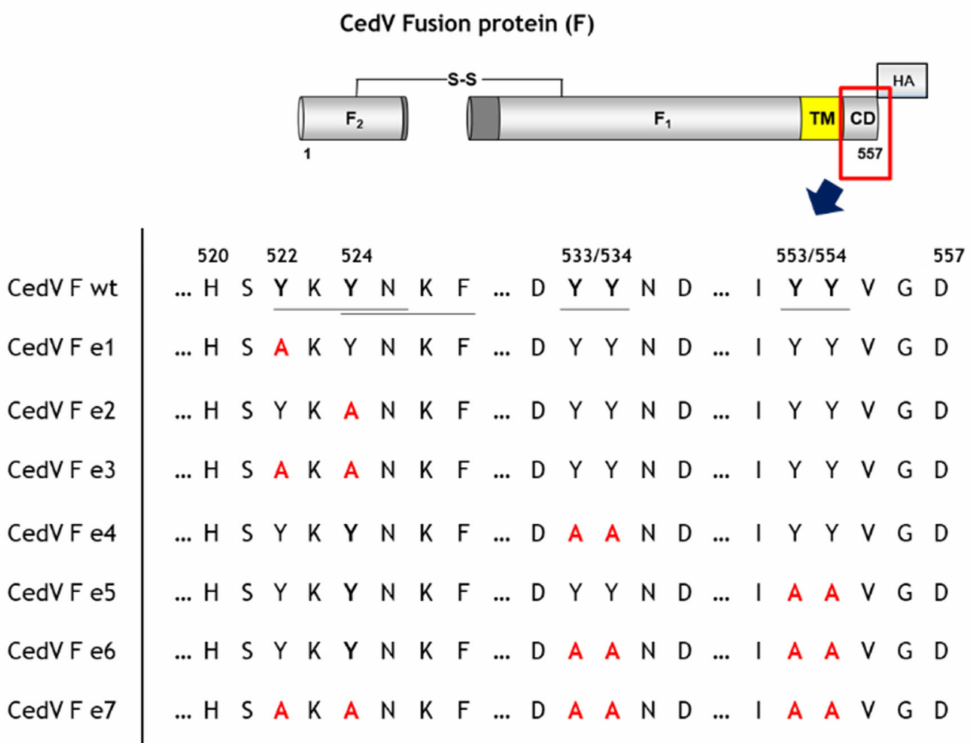
Figure 2. Schematic overview of the cytoplasmic tail mutants of CedV F protein generated in this study. Tyrosine-based putative endocytosis motifs are underlined. F 1 : CedV F protein subunit F 1 ; F 2 : CedV F protein subunit F 2 ; TM: transmembrane domain; CD: cytoplasmic domain; HA: HA-tag at the C-terminus of the F 1 subunit; S-S: di-sulfide bond. wt: